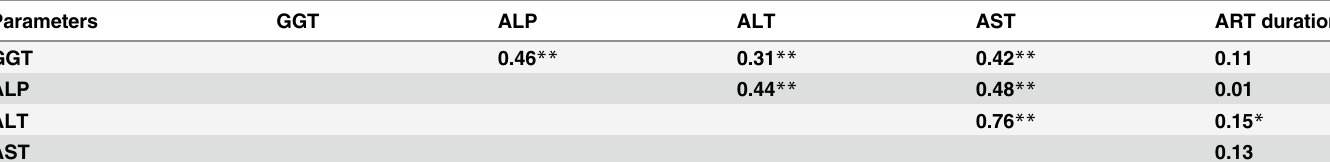
Table 5. Pearson ’ s correlation matrix showing the relationship between hepatic enzymes and duration of ART amongst HIV — ART participants. Parameters